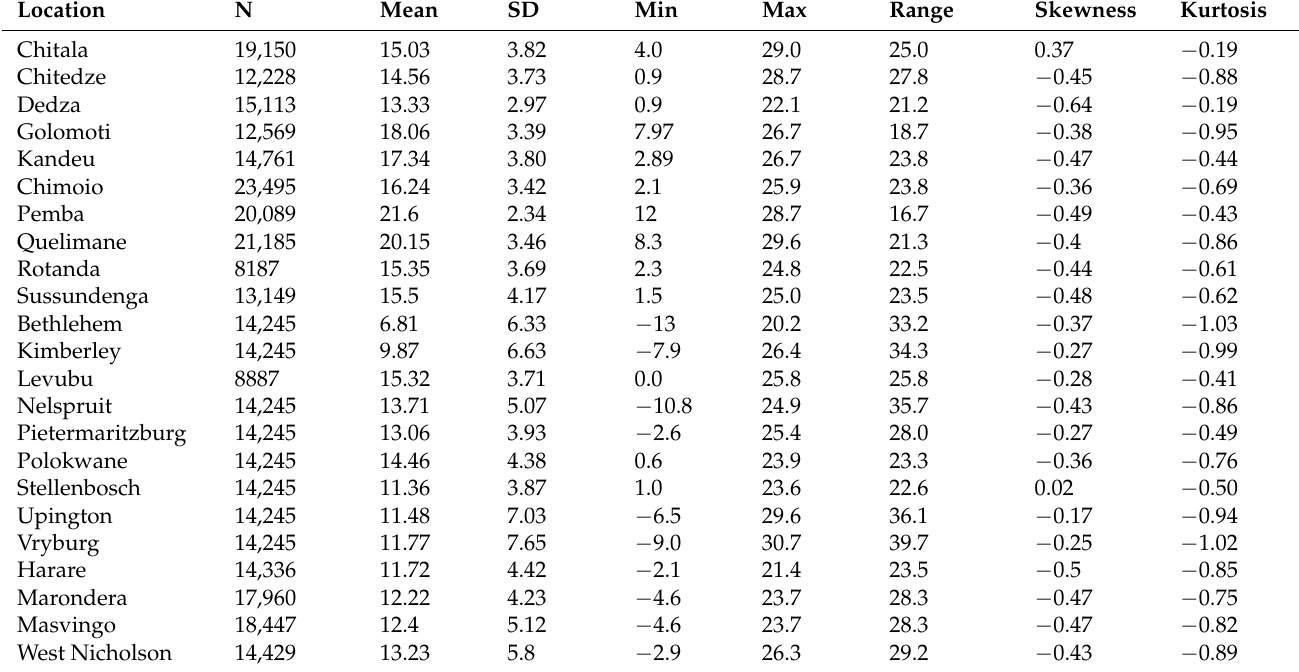
Table 3. Descriptive statistics for minimum temperatures measured at each of the meteorological stations in the four different